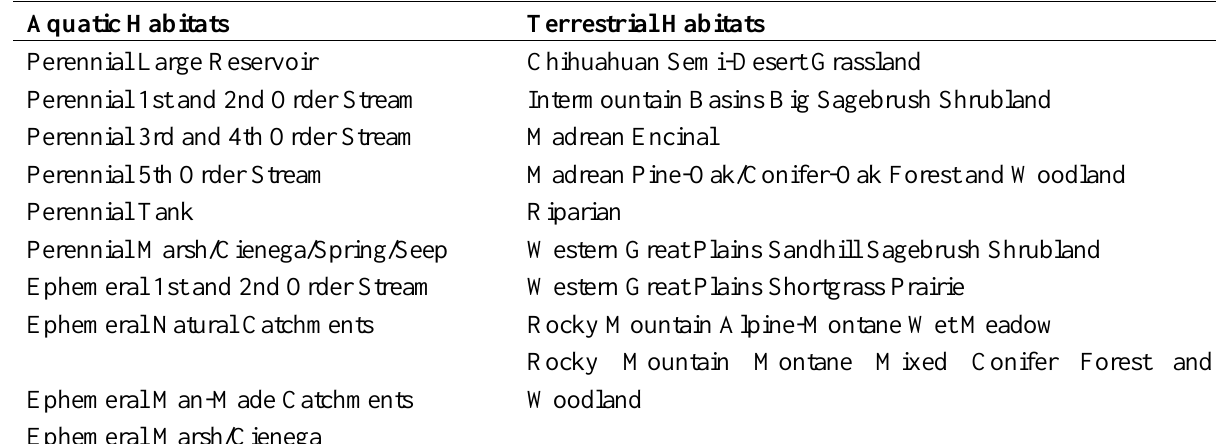
Table 2. Key aquatic and terrestrial habitats in New